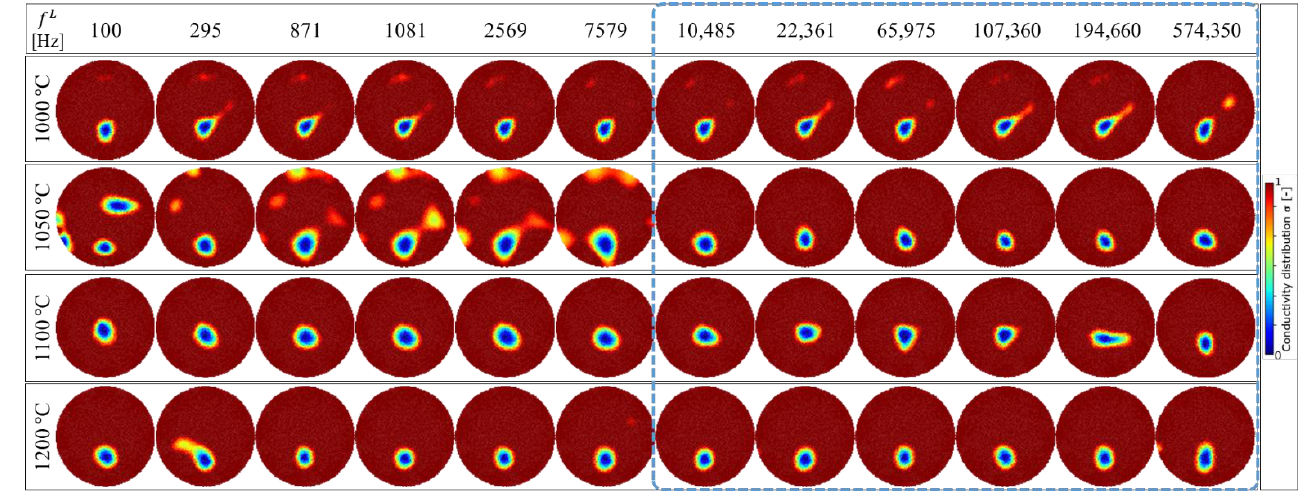
Figure 10. Image reconstruction result of σ in the case of the determined f H = 1,041,400 Hz with several f L frequencies at 1000~1200 ° C. Qualitatively, the satisfactory result occurred at f L ≥ 10,485 Hz.